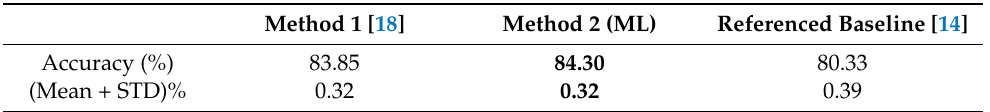
Table 1. Accuracy comparison with different methods adopted in XNOR-Net/ResNet-20 (Referenced Baseline) on CIFAR-10 database. The best results are shown in bold.